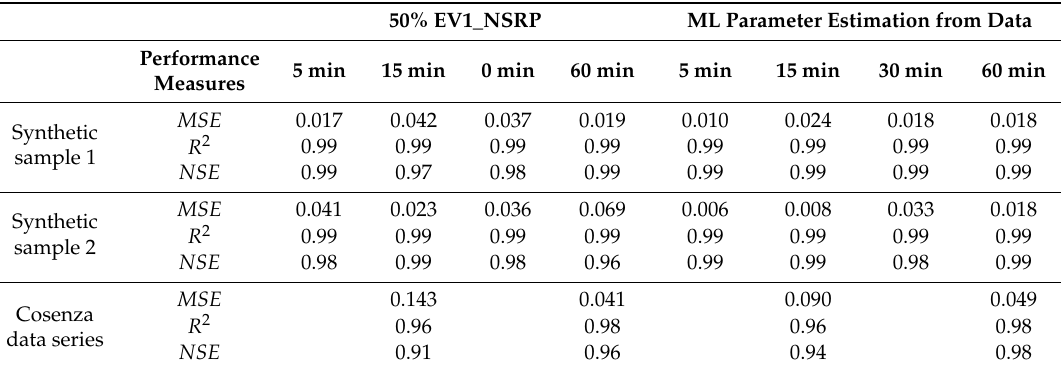
Table 7. Evaluation of EV1 distributions for synthetic samples and Cosenza data series.